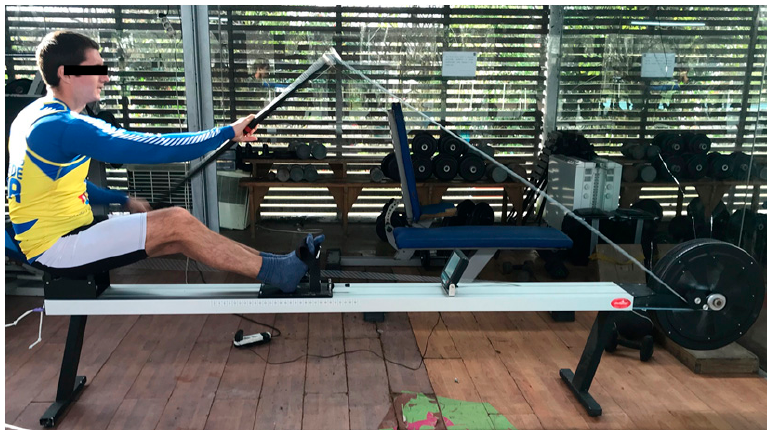
Figure 8. Ergometer for kayak simulation.